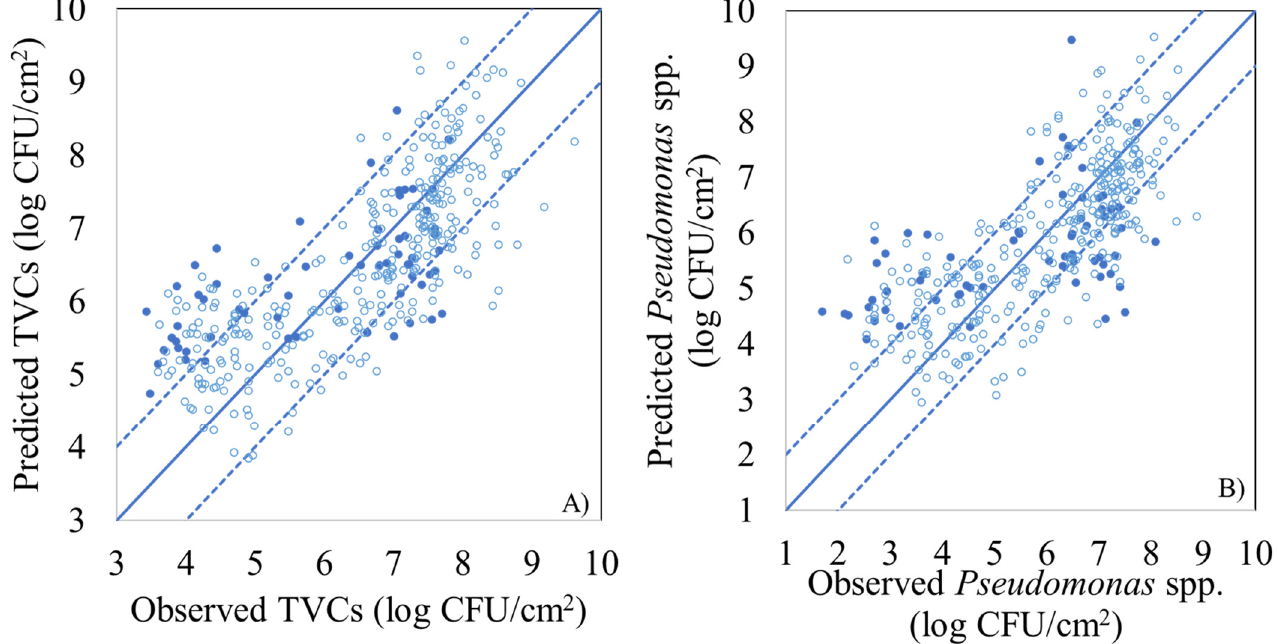
Figure 6. Predicted versus observed TVCs ( A ) and Pseudomonas spp. counts ( B ) by the PLS-R models, based on FT-IR data for FCV (open symbols) and prediction (solid symbols). Solid line represents the line of equity (y = x) and dashed lines indicate ± 1.0 log unit area.